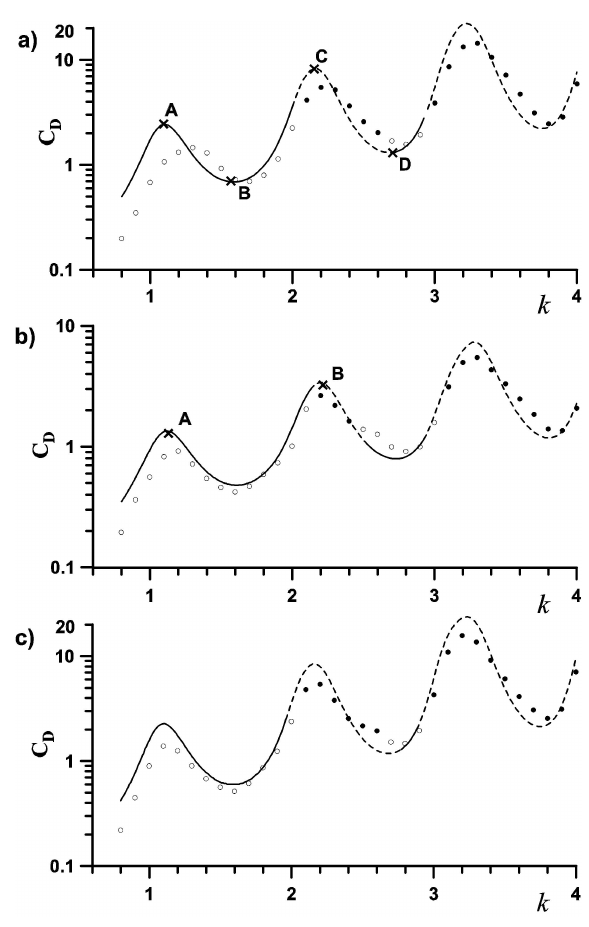
Fig. 3. Drag coefficient as a function of k for (a) , Ural, and (b) , (c) , Scandinavian mountains. Figures (a–c) correspond to the moun- tain profiles (a–c) shown in Fig. 2. The curves and circles are for the hydrostatic and non-hydrostatic solutions, correspondingly. The dashed curves and open circles mark the regions of k over which Long’s condition for a statically stable flow, Eq. (55), is violated. The points A–D in Fig. 3a and A, B in Fig. 3b correspond to the flow fields presented in Figs. 5a–d and Figs. 5a and